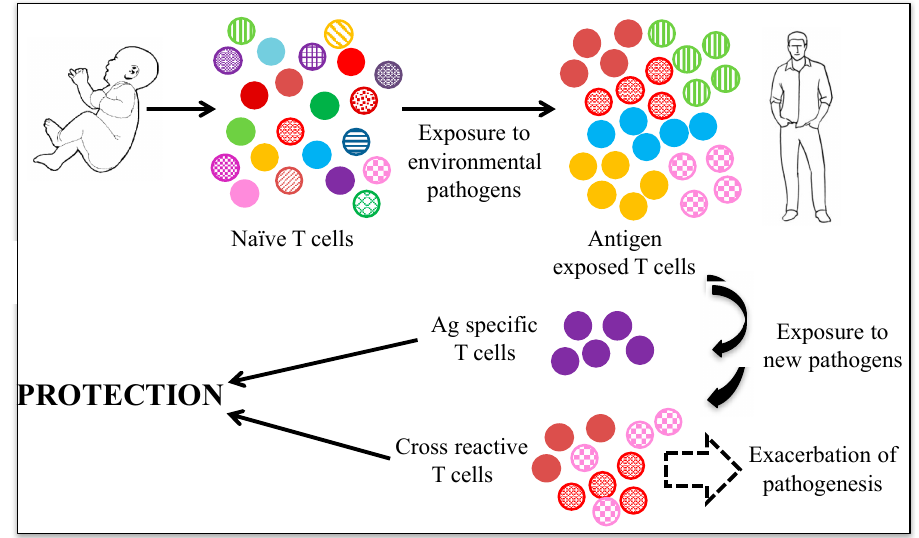
Figure 5. Heterologous immunity plays a significant role in protection from a new infection.